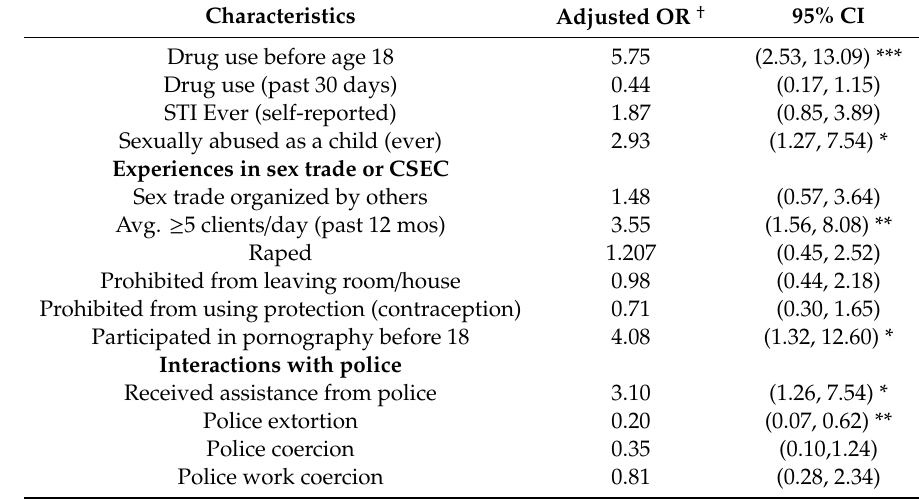
Table 2. Adjusted odds of being a minor at first sexual exploitation of Russian women in the sex trade in St. Petersburg and Orenburg, Russia ( N =